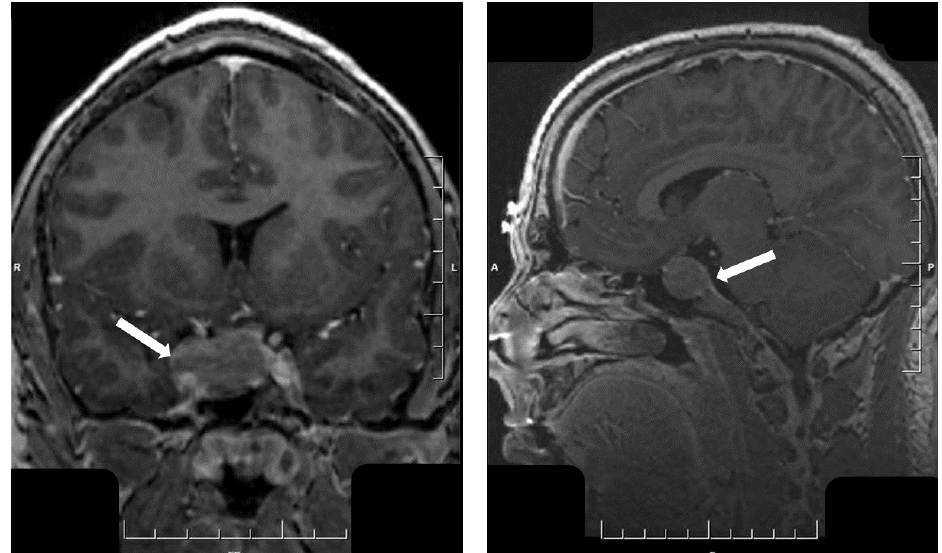
Figure 10. Magnetic resonance imaging of acidophil stem cell tumor. The large tumor that fills the sella turcica and extends into the right cavernous sinus ( left , arrow) and characteristically downwards into the sphenoid sinus ( right , arrow), was associated with hyperprolactinemia but not proportional to the tumor size; biochemical assessment documented mild elevation of IGF-1.